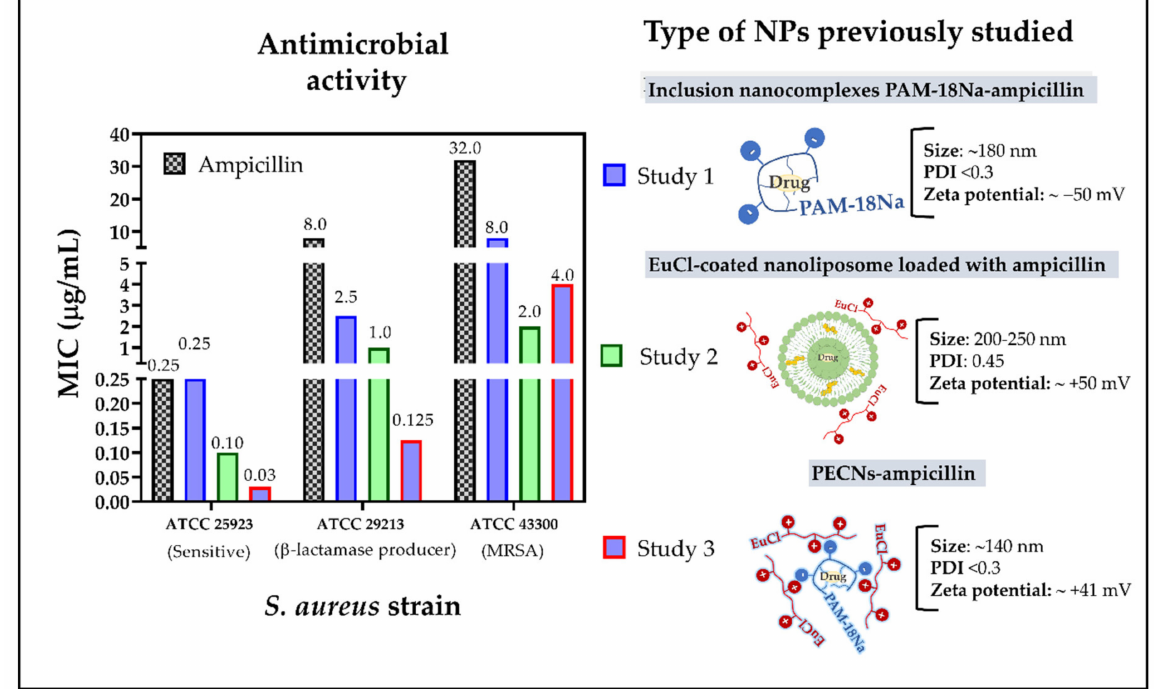
Figure 2. Results of the minimum inhibitory concentrations (MIC) of different NPs developed in previous studies on S. aureus strains with different degrees of